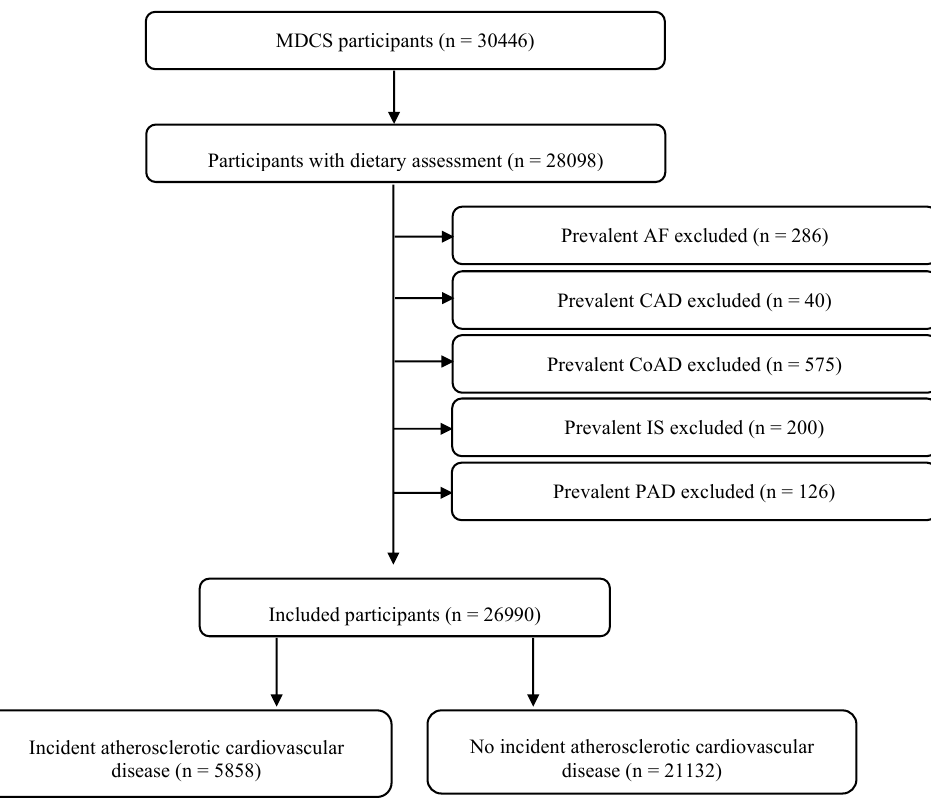
Figure 1. Descriptive flow diagram of study participants, dietary data and exclusions. MDCS: Malmö Diet and Cancer Study; AF: atrial flutter or fibrillation; CAD: carotid artery disease; CoAD: coronary artery disease; IS: ischemic stroke; PAD: peripheral artery disease. Some individuals had multiple exclusion criteria.